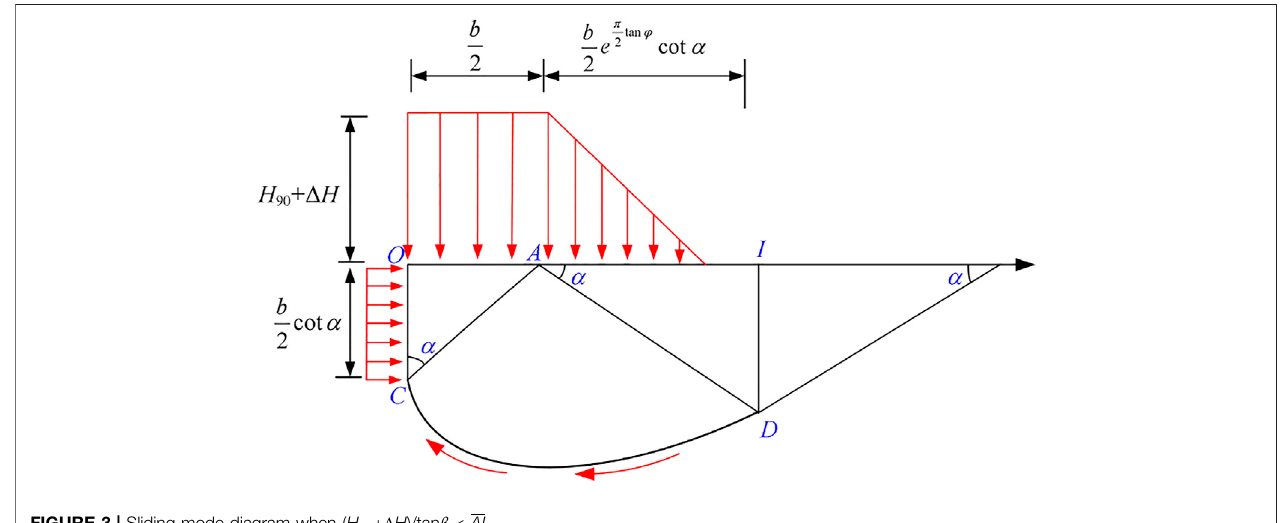
FIGURE 3 | Sliding mode diagram when ( H 90 + Δ H )/tan β < AI